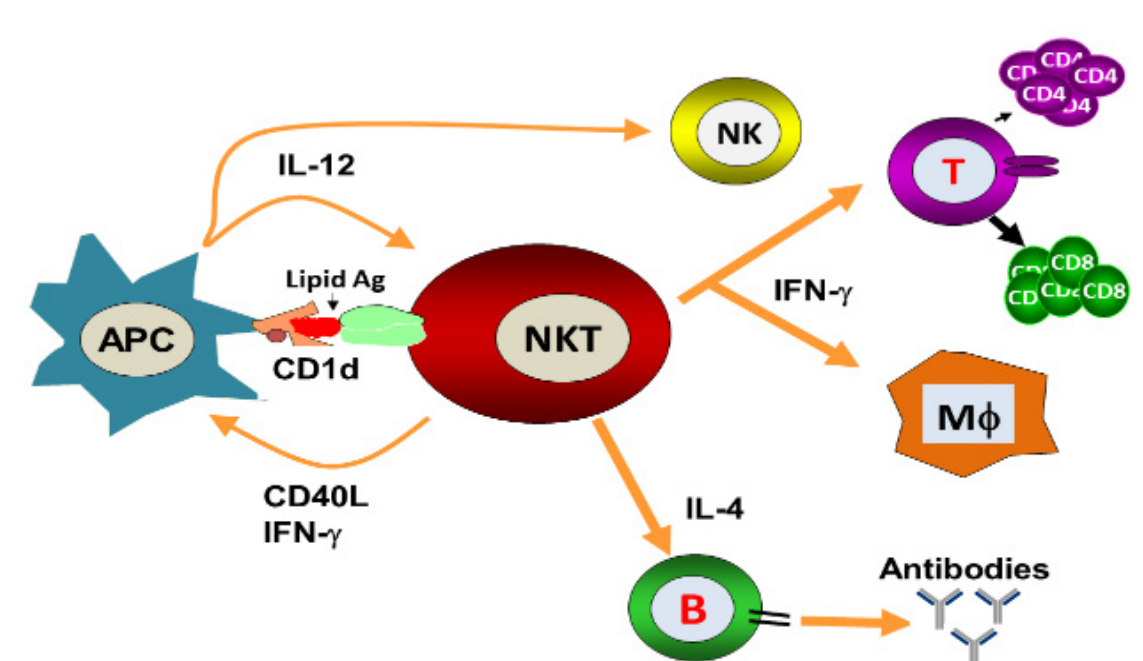
Figure 1. Activation of NKT cells results in the secretion of Th1 and Th2 cytokines. Lipid antigens presented by CD1d activate NKT cells, resulting in the secretion of IFN- γ and IL-4. IFN- γ activates the T cells and macrophages that are important players in cell-mediated immunity, whereas IL-4 acts on B cells and contributes to humoral immunity.